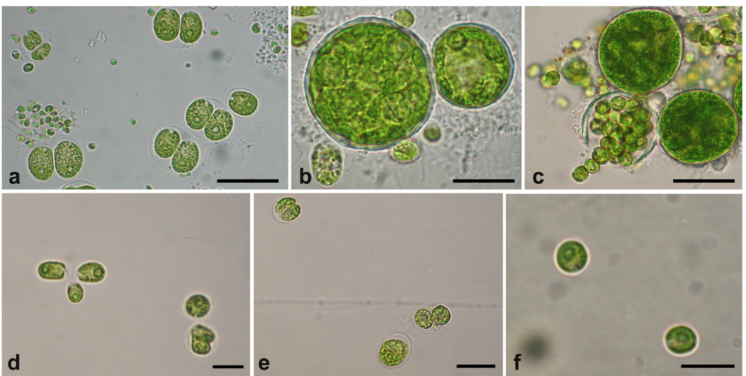
Figure 1. Overall view of the most characteristic microalgal forms collected from the UWW. ( a – d ) Microalgal forms from the upper layer; ( e , f ) microalgal forms from the lower layer. Bars: ( a – c ), 20 µ m; ( d , e ), 10 µ m; ( f ), 5 µ m.